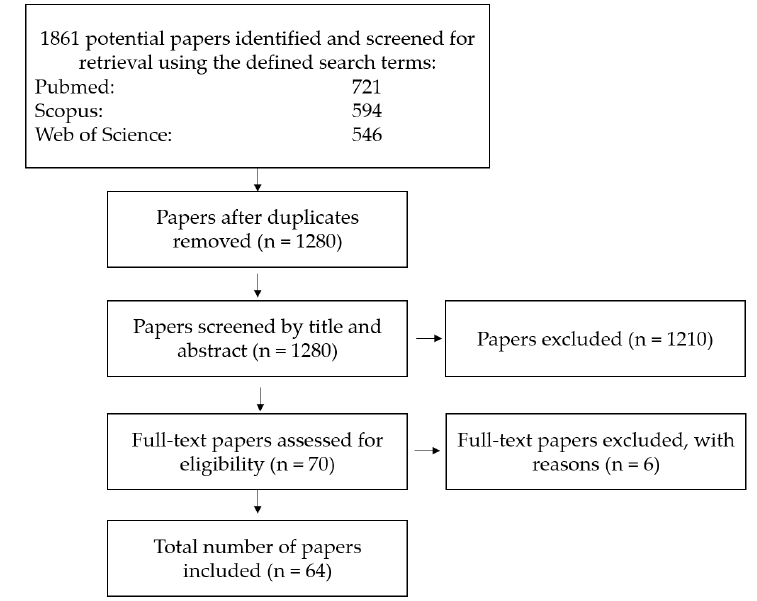
Figure 1. PRISMA flow diagram for the study selection procedure.